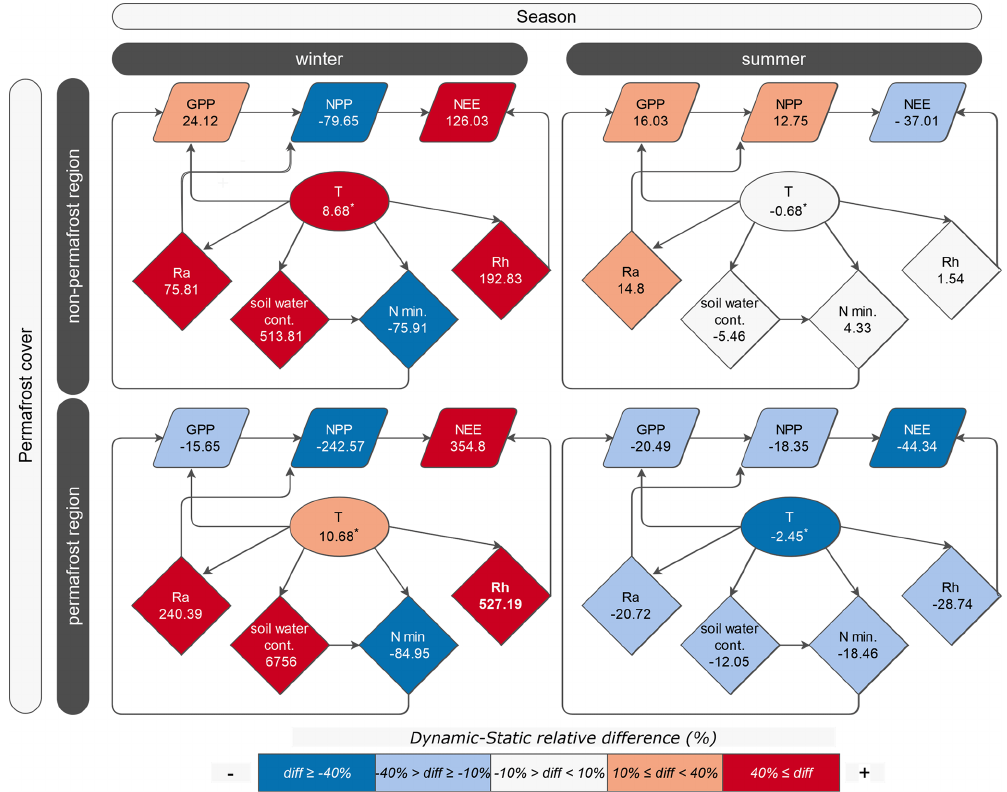
Figure 12. Relationship between variables during the winter and summer seasons, within and outside of the permafrost region. The colour of the boxes indicates the direction and qualitative magnitude of changes in the variables, based on the relative difference (%) between Dynamic and Static schemes – shown in the boxes below the variables. Variables are shown as follows: GPP: gross primary production (gm − 2 ); NPP: net primary productivity (gm − 2 ); NEE: net ecosystem exchange (gm − 2 ); R a : autotrophic respiration (gm − 2 ); R h : heterotrophic respiration (gm − 2 ); N min : net nitrogen mineralization (kgNha − 1 ); soil water content: fraction . The relative changes in soil water content (in %) are high in the winter due to the low fractional water content values as we only account for the liquid soil water and do not consider the amount of frozen water in the soil. These changes correspond to small absolute changes in fractional soil water content. ∗ Note: temperature differences are shown as absolute differences for easier